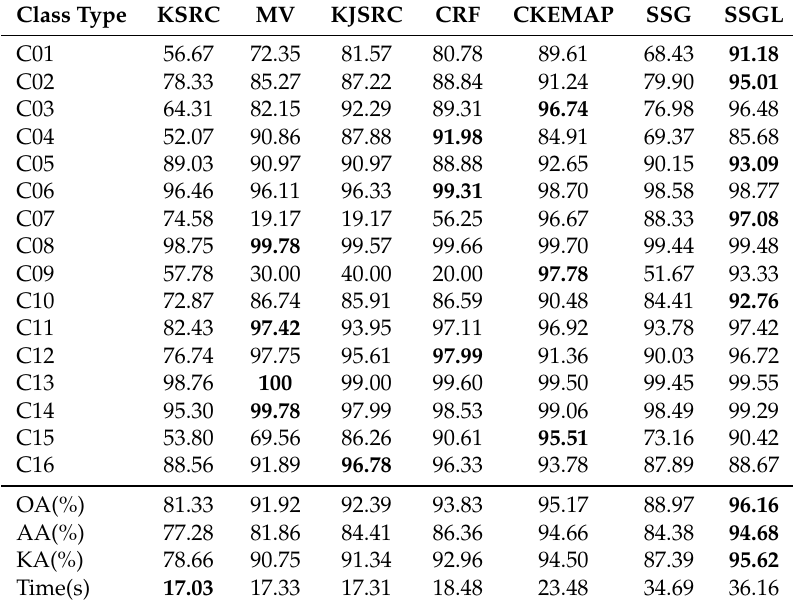
Table 5. Classification accuracies for the AVIRIS Indian Pines dataset using different classification methods. The best results are highlighted in bold. AA: average accuracy; CKEMAP: composite kernel with extended multi-attribute profile features; CRF: condition random fields; KA: kappa coefficient of agreement; KSRC: kernel sparse representation classification; KJSRC: kernel joint SRC; MV: majority voting; OA: overall accuracy; SSG: spatial-spectral graph regularization with location information; SSGL: spatial-spectral graph regularization with location